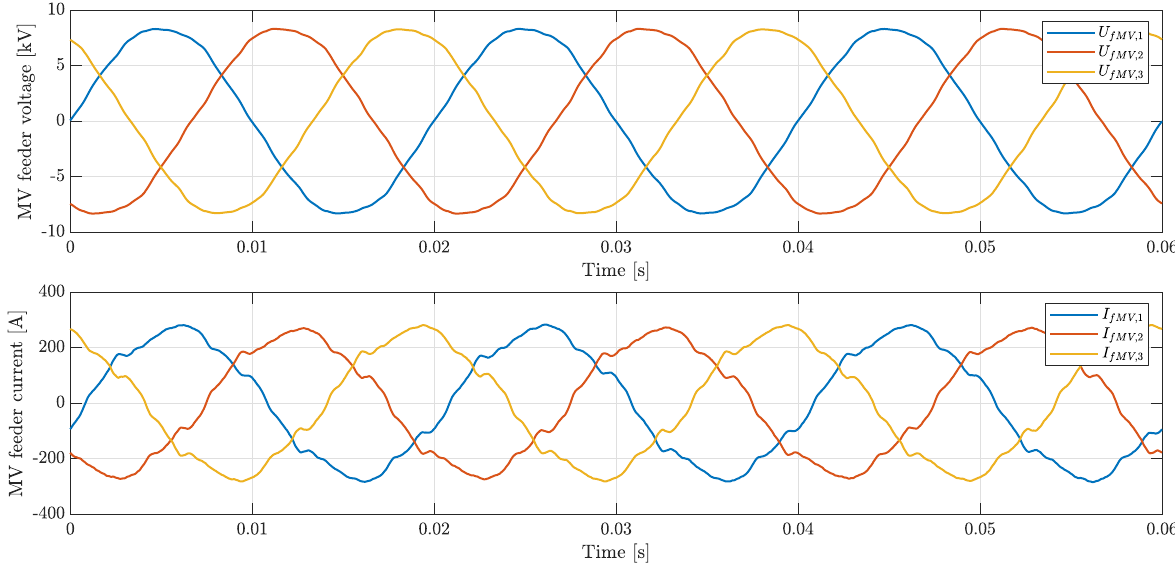
Figure 20. C2—Medium voltage feeder voltage and current in ferroresonance steady